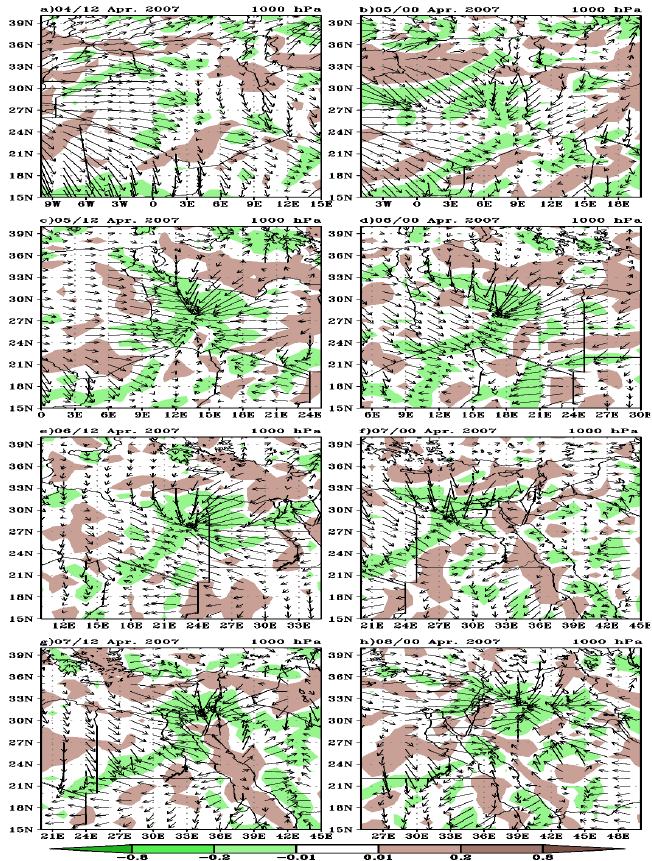
Figure 10. Divergent component of wind (m/s) (black arrow) at 1000 hPa. The shaded areas are the divergent (source) and convergent (sink) for 12Z and 00Z for 4–8 April 2007. (Unit: 10 − 3 × s − 1 for divergent or convergent).